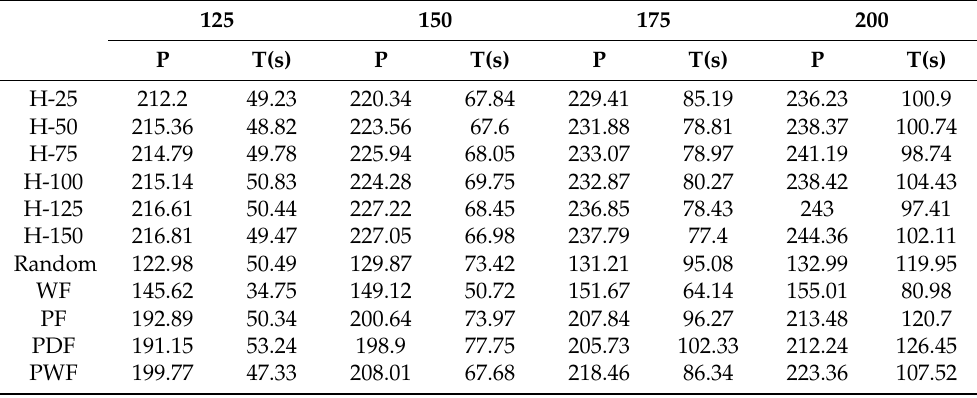
Table 7. Experimental results of scenarios with different scales for scale from 125 to 200.